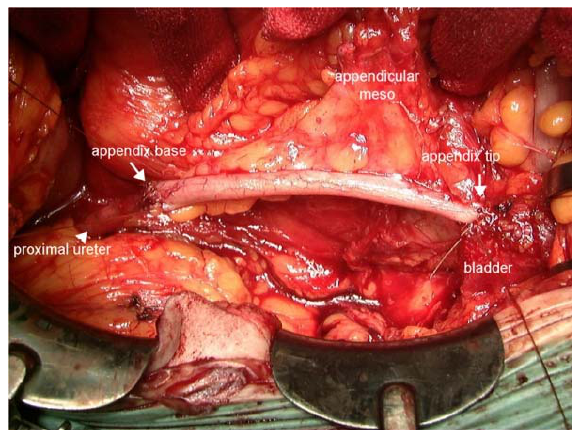
FIGURE 2. Antiperistaltic interposition of the appendix.